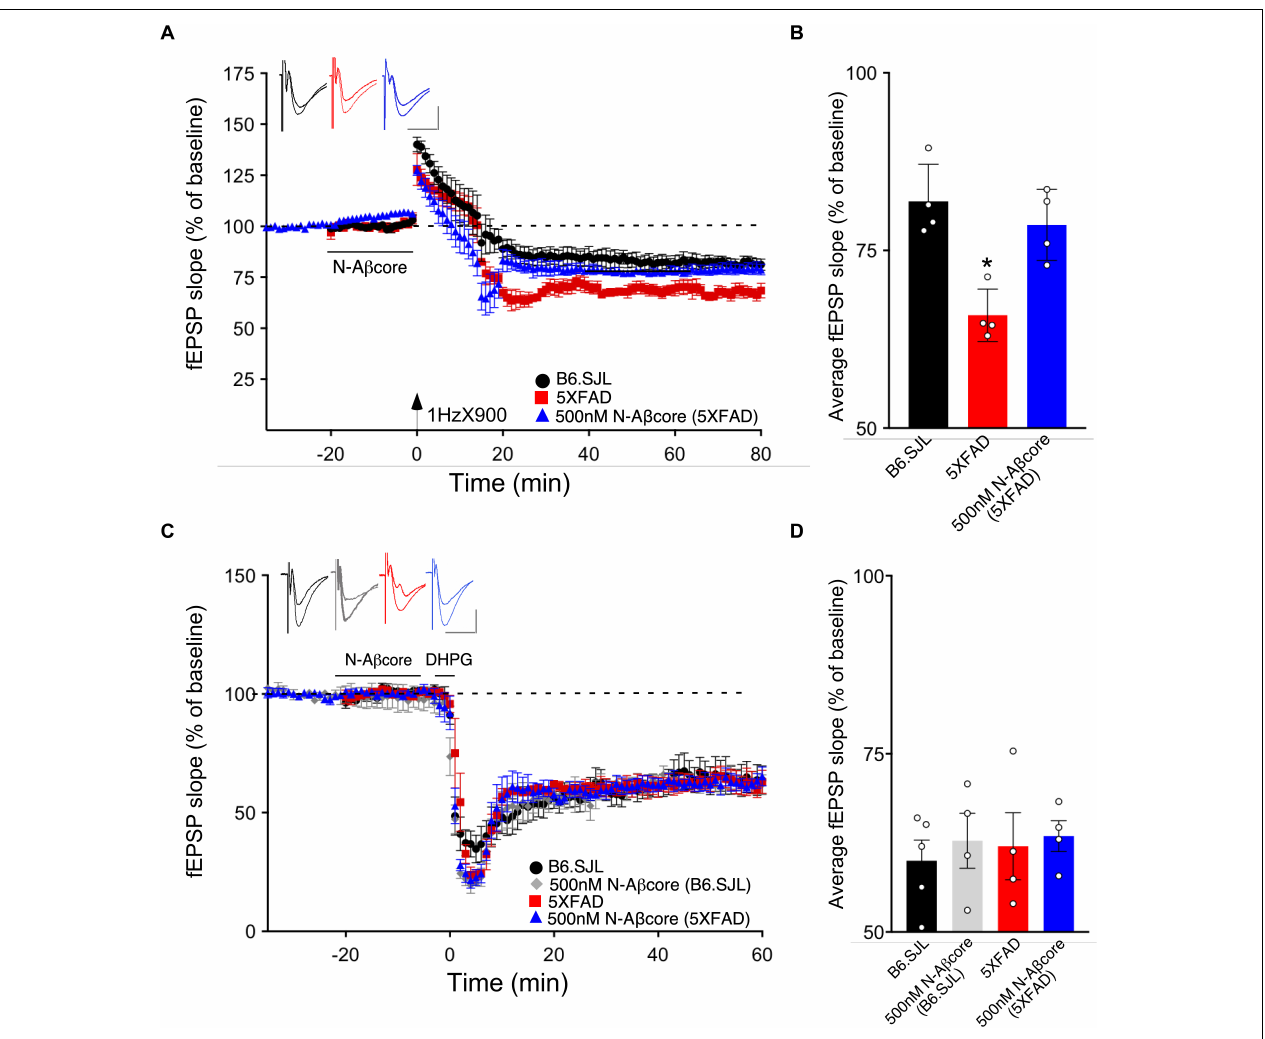
FIGURE 6 | The N-A β core reverses endogenous A β enhancement of LTD, but has no impact on NMDA-independent, metabotropic glutamate receptor-induced LTD deficits. (A) LFS-induced LTD in hippocampal slices from B6.SJL perfused with control aCSF (black) and 5xFAD slices perfused with aCSF (red) or 500 nM N-A β core (blue). Color-coded insets show examples of fEPSPs (baseline vs. LTD). (B) Quantification of average fEPSP slope values for 50–60 min post-LFS (one-way ANOVA F ( 2 , 9 ) = 13.03, p = 0.0022). Bonferroni post hoc tests: 5xFAD slices displayed significantly more pronounced LTD as compared to control aCSF B6.SJL slices (* p = 0.012). 500 nM N-A β core in 5xFAD slices returned LTD to the level observed in control aCSF-perfused B6.SJL slices ( p > 0.99). Data are mean ± SEM. N = 4 for each condition (1 slice/mouse). Inset calibration: horizontal, 10 ms; vertical, 0.4 mV. * p < 0.05. (C) NMDA-independent, 3,5-dihydroxyphenylglycine (DHPG, metabotropic glutamate receptor group I agonist; 100 µ M)-induced LTD in hippocampal slices from B6.SJL mice perfused with control aCSF (black) or 500 nM N-A β core (gray) and 5xFAD slices perfused with aCSF (red) or 500 nM N-A β core (blue). Color-coded insets show examples of fEPSPs (baseline vs. LTD). Inset calibration: horizontal, 10 ms; vertical, 0.4 mV. (D) Quantification of average fEPSP slope values for 50–60 min post-LFS ( p < 0.05, two-way ANOVA). Data are means ± SEM. N = 4 for each condition (1